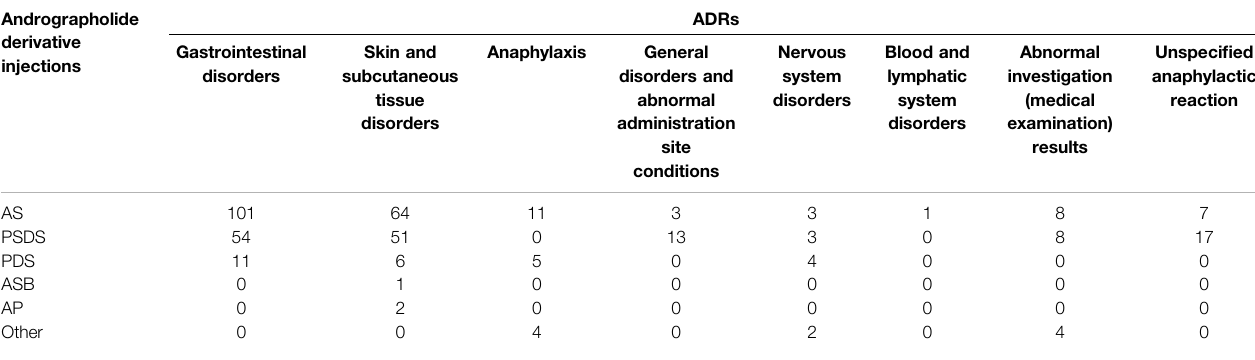
TABLE 2 | ADRs of andrographolide derivative injections reported in the included RCTs, non-RCTs and case series. Andrographolide